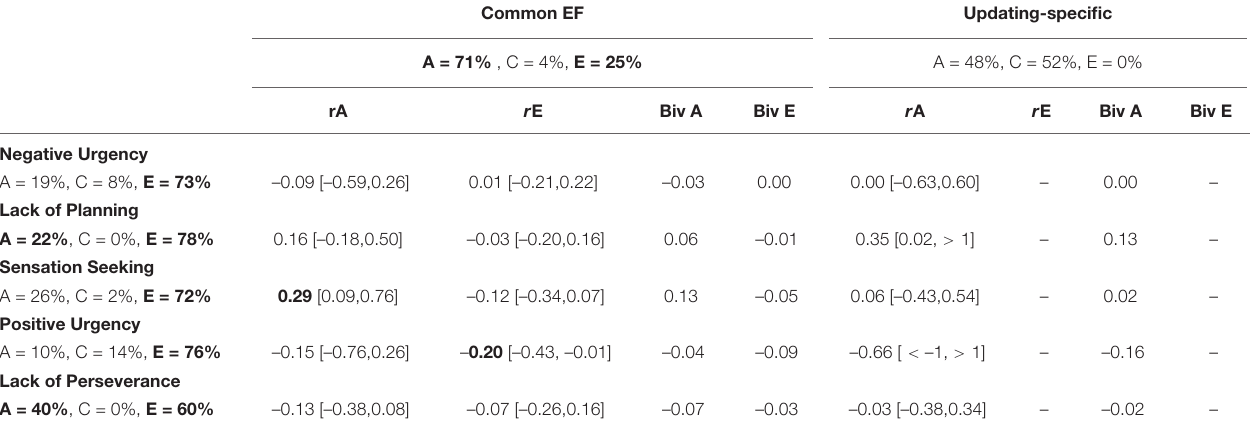
TABLE 5 | Genetic and Non-shared environmental correlations of executive function latent variables and UPPS-subscales. Common EF Updating-specific